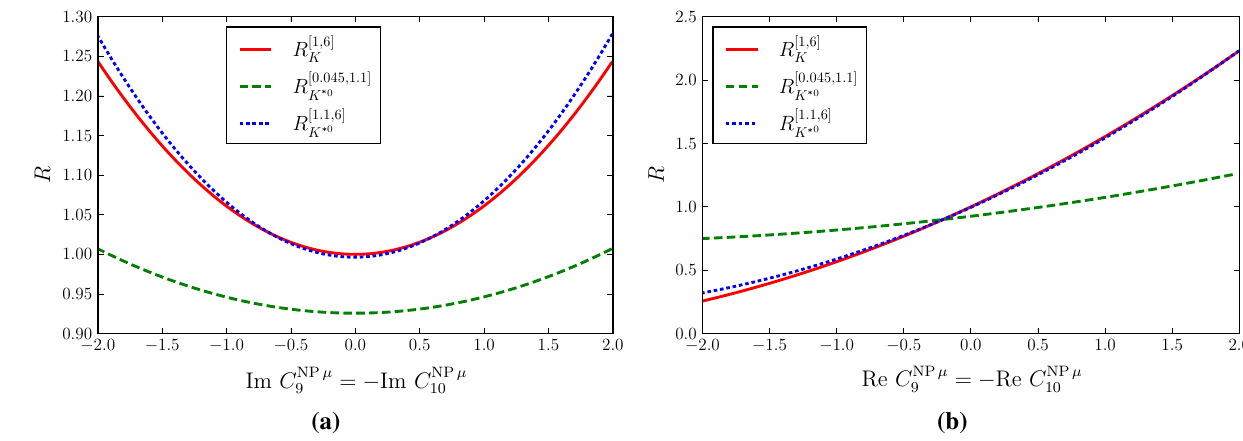
Fig. 1 Values of R K and R K ∗ 0 with a imaginary and b real Wilson coefficients